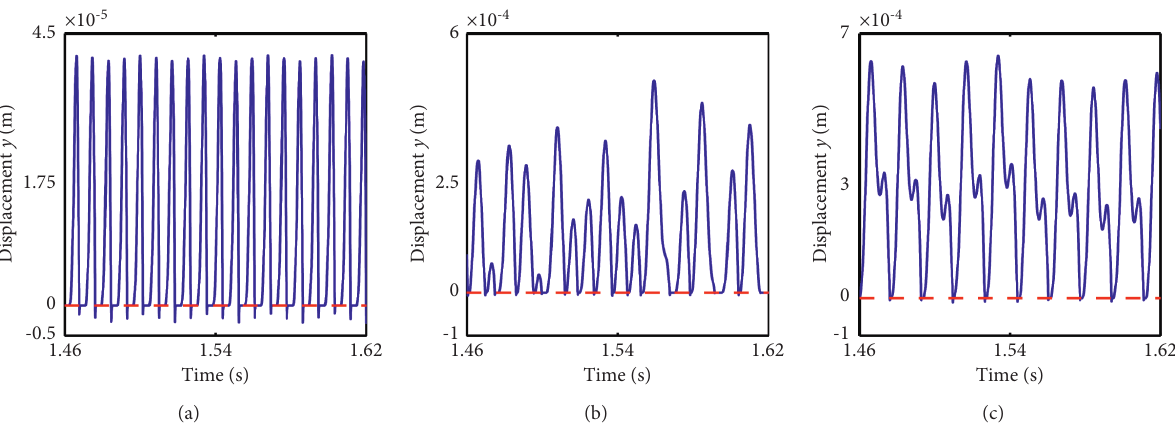
Figure 13: Vibration waveforms of the right bearing support with the change of the unbalance of two discs. (a) e � 0.1 × 10 –3 m, (b) e � 0.3 × 10 –3 m, and (c) e � 0.9 × 10 –3